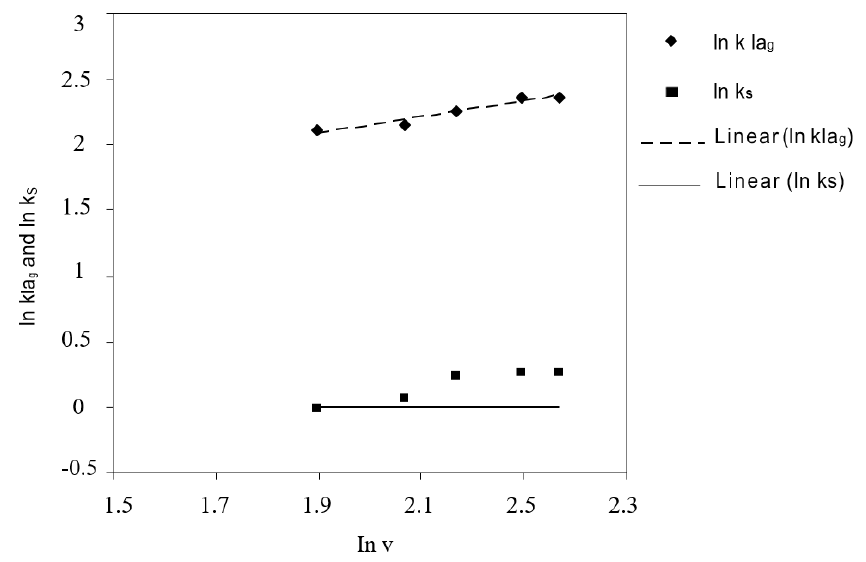
Figure 5. The relationship between ln k l a g and ln k s with ln